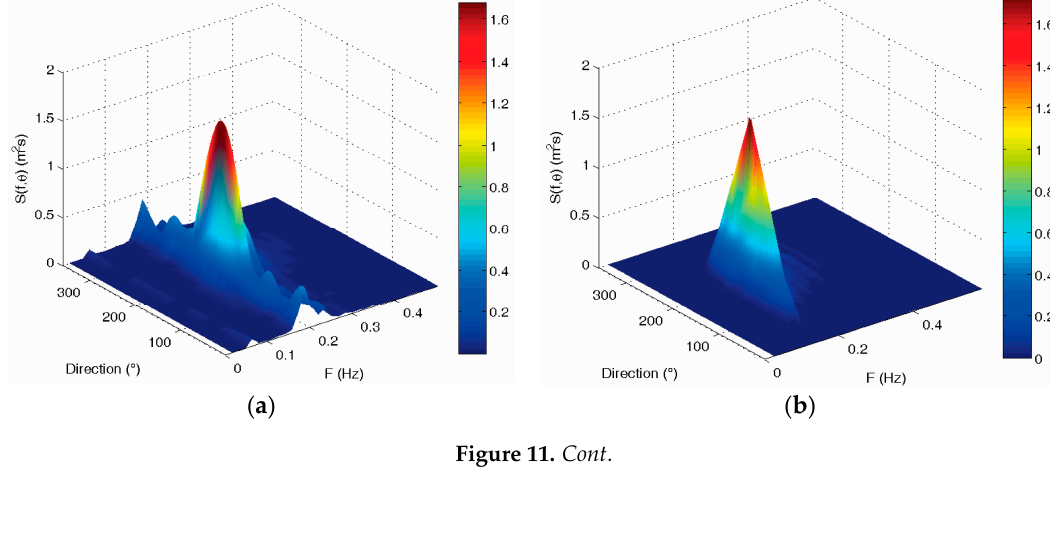
Figure 10. Comparison of wave frequency spectrum between the SBF7-1A GPS wave buoy and the DWR-MKIII Waverider buoy after correction at 03:00 (UTC) on 2 July 2013.